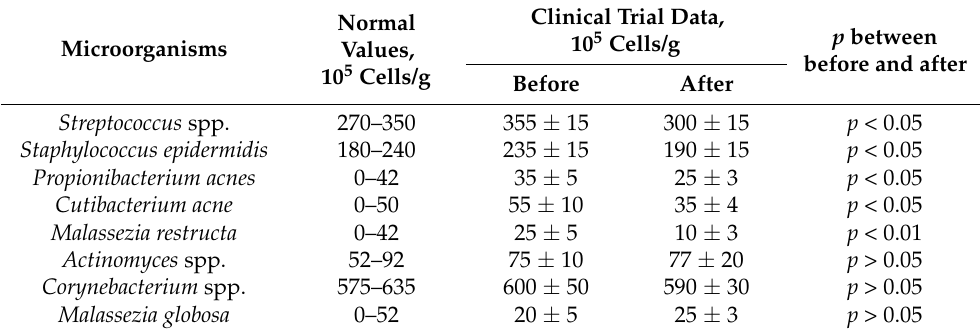
Table 7. Microbiota-correcting effects of the experimental hair care cosmetics. Microorganisms